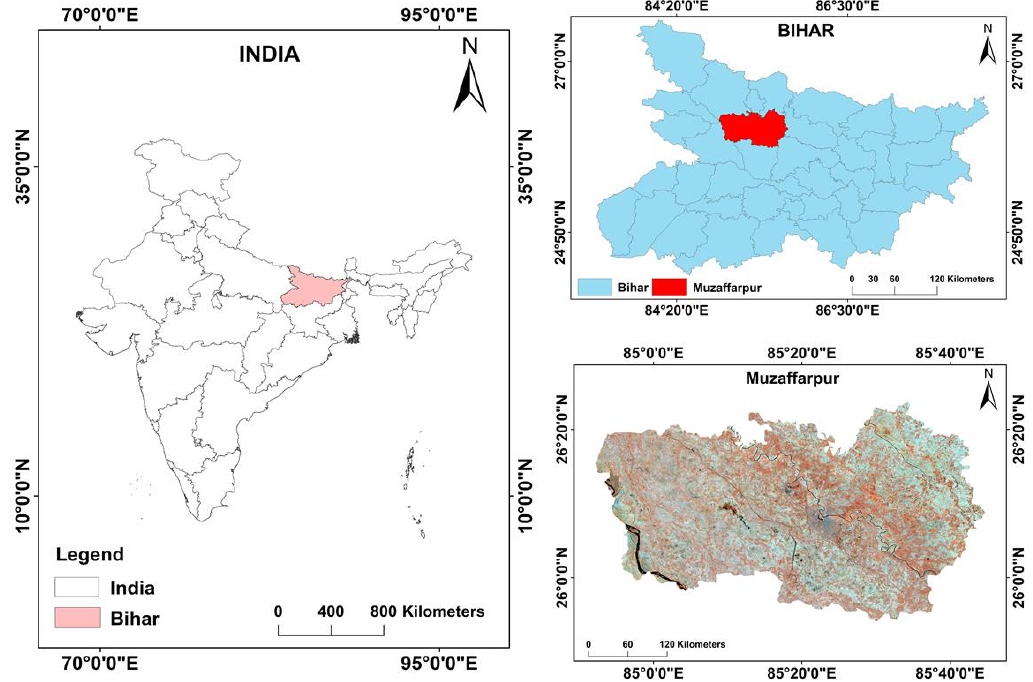
Figure 1. Location of the study area in relation to India and the state of Bihar.